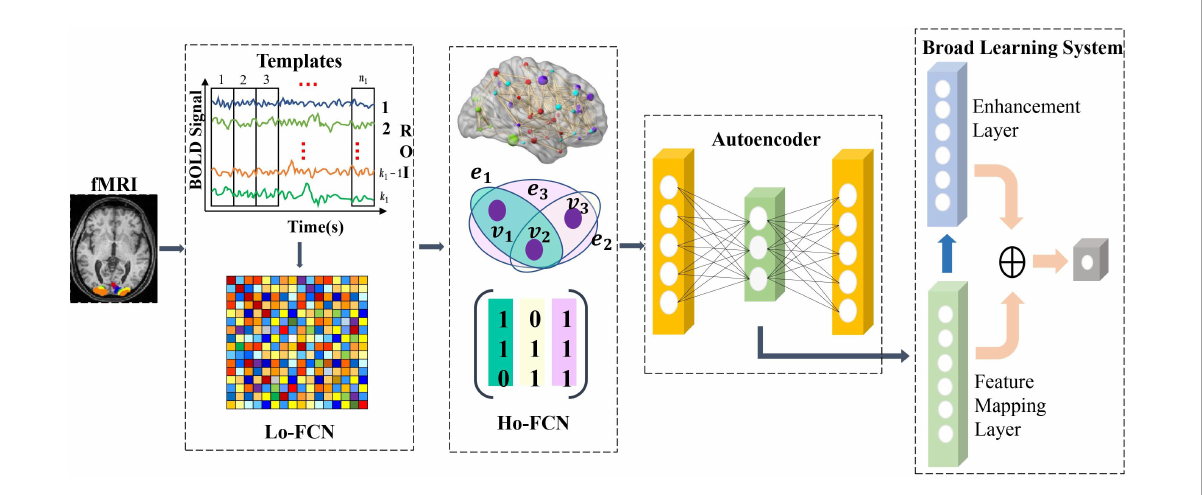
FIGURE1 The illustration of our proposed method.